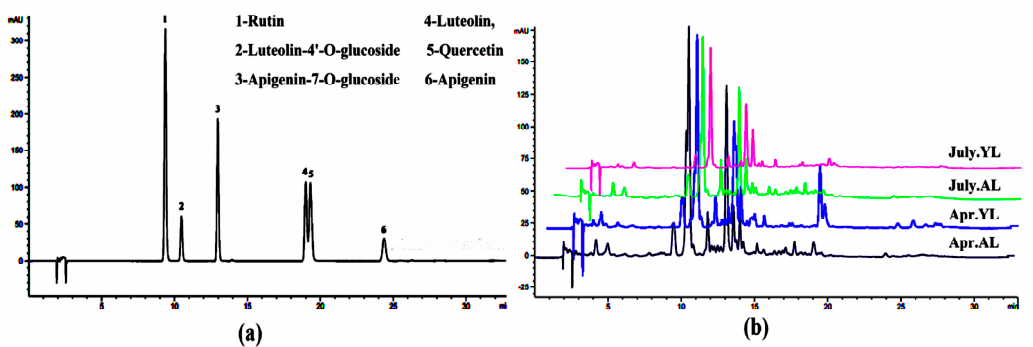
Figure 3. HPLC chromatograms of flavonoid compounds: ( a ) mixture standard; ( b ) samples from the aged and young leaves (AL and YL) in April and July.